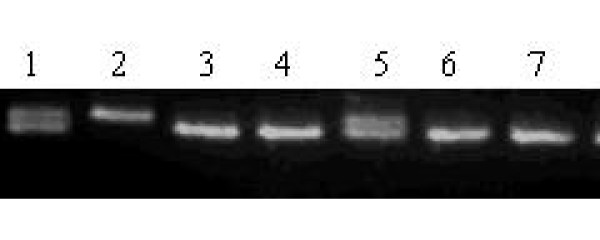
Lane 1 and 5 represents heterozygous Gly/Trp genotypes, lane 2 represents homozygous Gly/Gly genotypes, lane 3, 4, 6 and 7 represents homozygous Trp/Trp genotypes of Gly460Trp polymorphism of alpha-adducin gene.